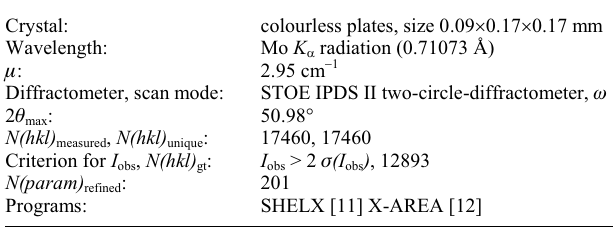
Table 1. Data collection and handling.